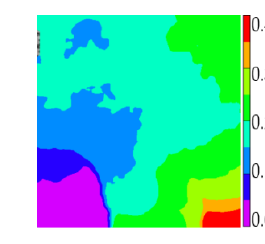
Figure 14. The horizontal strain cloud diagram of concrete with different coarse aggregate volume fraction at the peak point of damage stage II, ( a ) 0 %, ( b ) 20 %, ( c ) 40 %, ( d ) 60 %.